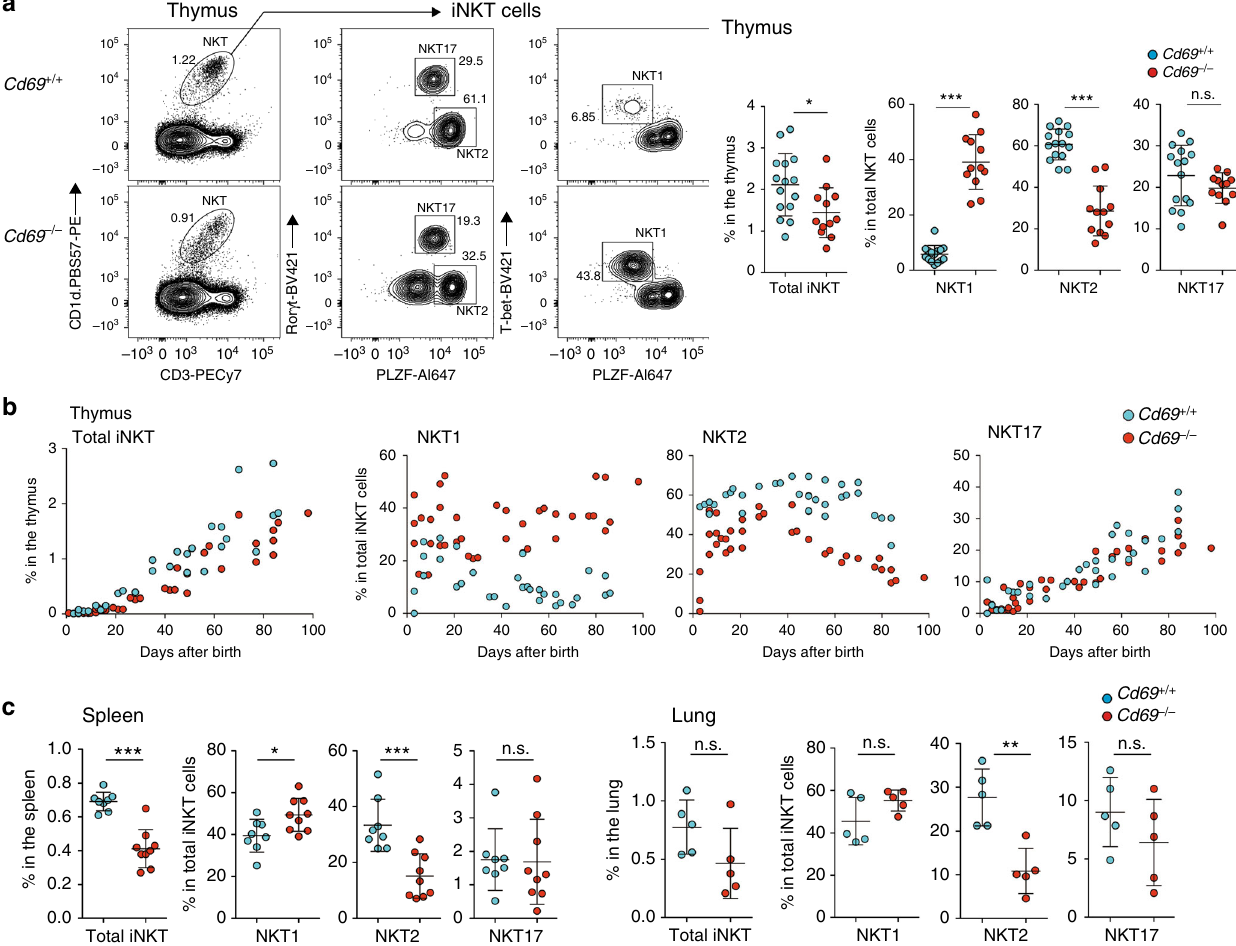
Fig. 3 Diminished NKT2 cell differentiation in Cd69 – / – mice. a , c Pro fi les of iNKT subsets in the thymus ( a ) and frequencies of iNKT subsets in the spleen and lung ( c ) from Cd69 + / + and Cd69 – / – BALB/c-background mice. The total frequency of iNKT cells and the frequencies of NKT1 (PLZF lo T-bet + ), NKT2 (PLZF hi Ror γ t med ), and NKT17 (PLZF med Ror γ t hi ) cells among total iNKT cells are shown. b Ontogeny of iNKT subsets in BALB/c thymus, showing the total frequency of iNKT cells and the frequencies of NKT1 (PLZF lo T-bet + ), NKT2 (PLZF hi Ror γ t med ), and NKT17 (PLZF med Ror γ t hi ) cells among iNKT cells up to 100 days after birth. The mean and SEM are shown. * p < 0.05, ** p < 0.01, and *** p < 0.001 (two-tailed unpaired t test). Representative data from 8 to 11 experiments with more than 10 mice is shown ( a ). Data are pooled from more that 10 experiments with 30 ( Cd69 + / + ) or 37 ( Cd69 – / – ) mice ( b ), 4 – 8 experiments with more than 8 mice (spleen), or 5 mice (lung) ( c ). n.s. not signi fi